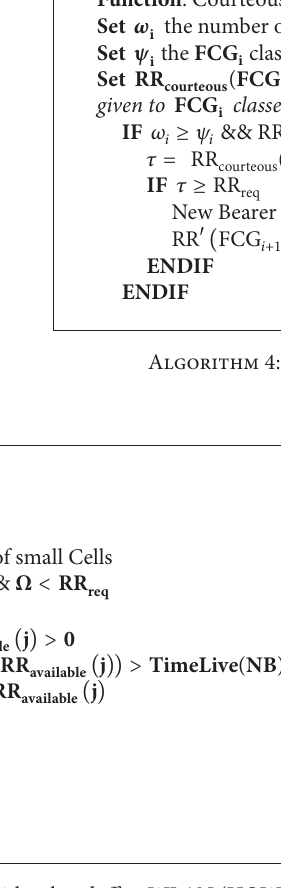
Algorithm 5: Algorithm handoff to WLAN